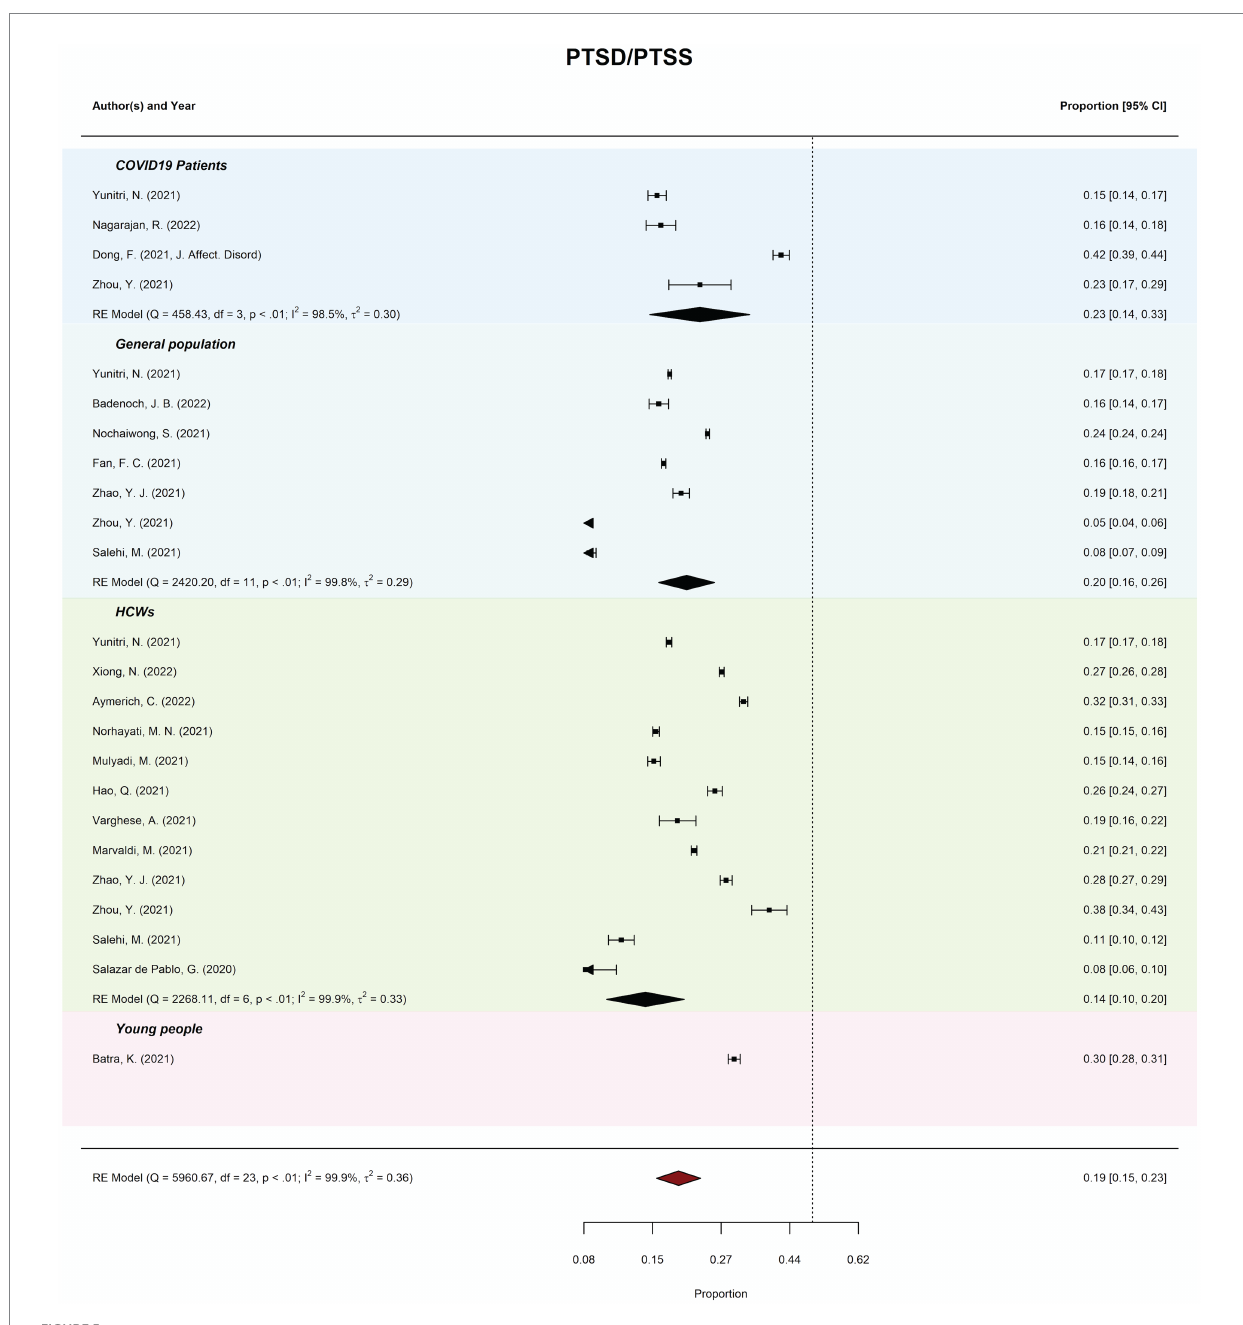
FIGURE 5 Meta-review of pooled prevalence of PTSD/PTSS. The forest plots of the prevalence (and 95% CIs) of probable post-traumatic stress disorder (PTSD) combined with post-traumatic stress symptoms (PTSS) (PTSD/PTSS) across all